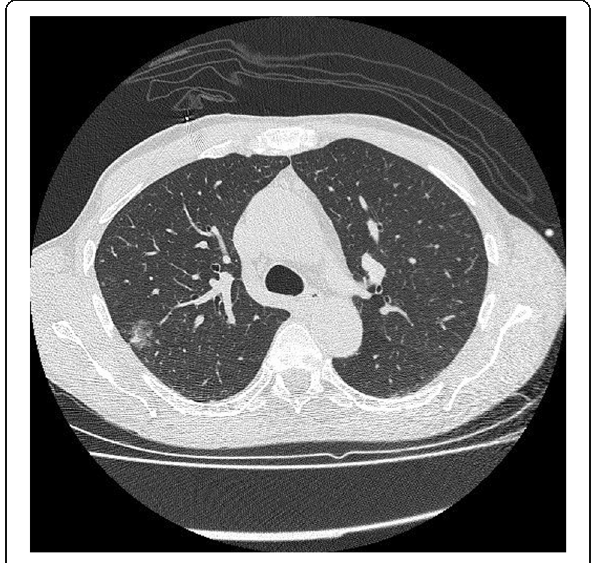
Fig. 6 MIA on CT: 9 mm part-solid subpleural nodule, predominantly solid, in the left lower